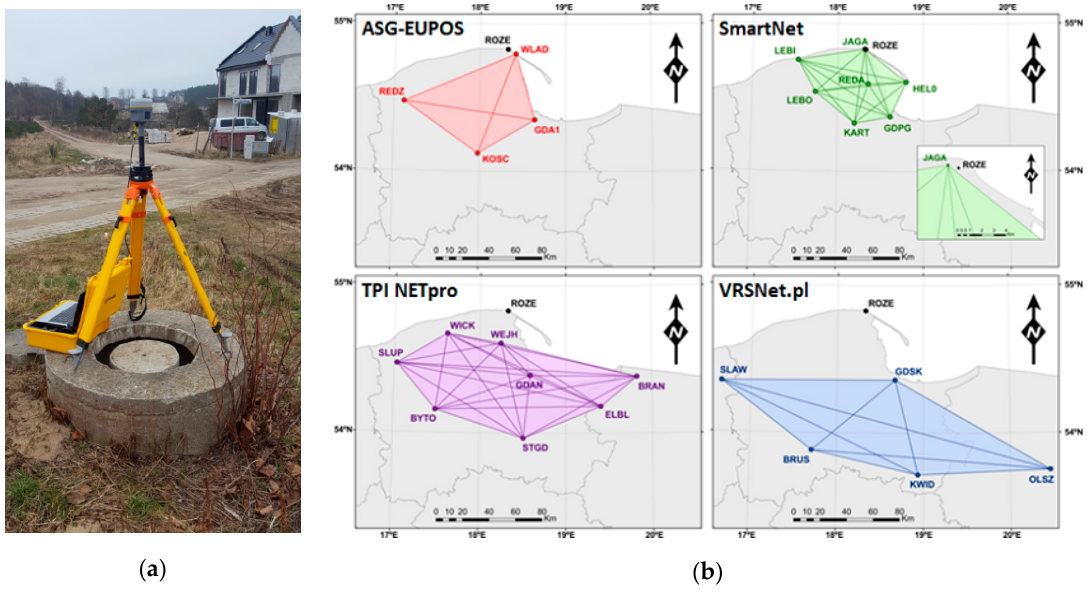
Figure 10. The measuring site ( a ) and the borders of a polygon which marks the operating range for individual GNSS geodetic networks in the province of Pomerania ( b ).